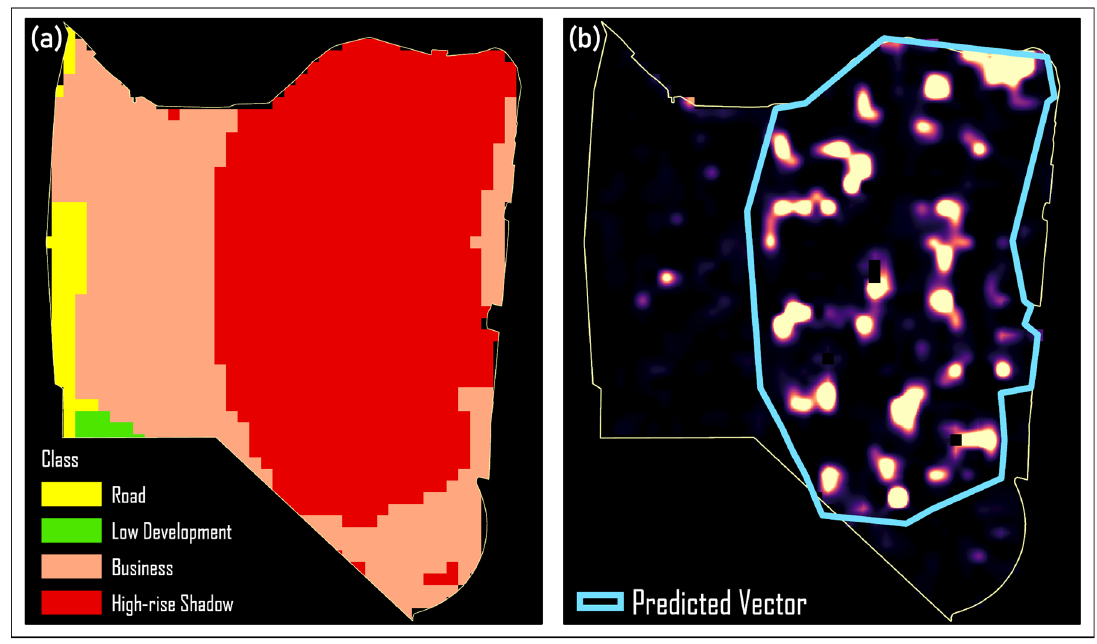
Figure 13. Results of LCM 2016 prediction for Brickell neighborhood area of interest based on 2003 and 2008 data; ( a ) predicted 2016 area of interest land cover, ( b ) vector derived from 2016 prediction referencing the formation of shadows in the area of interest.